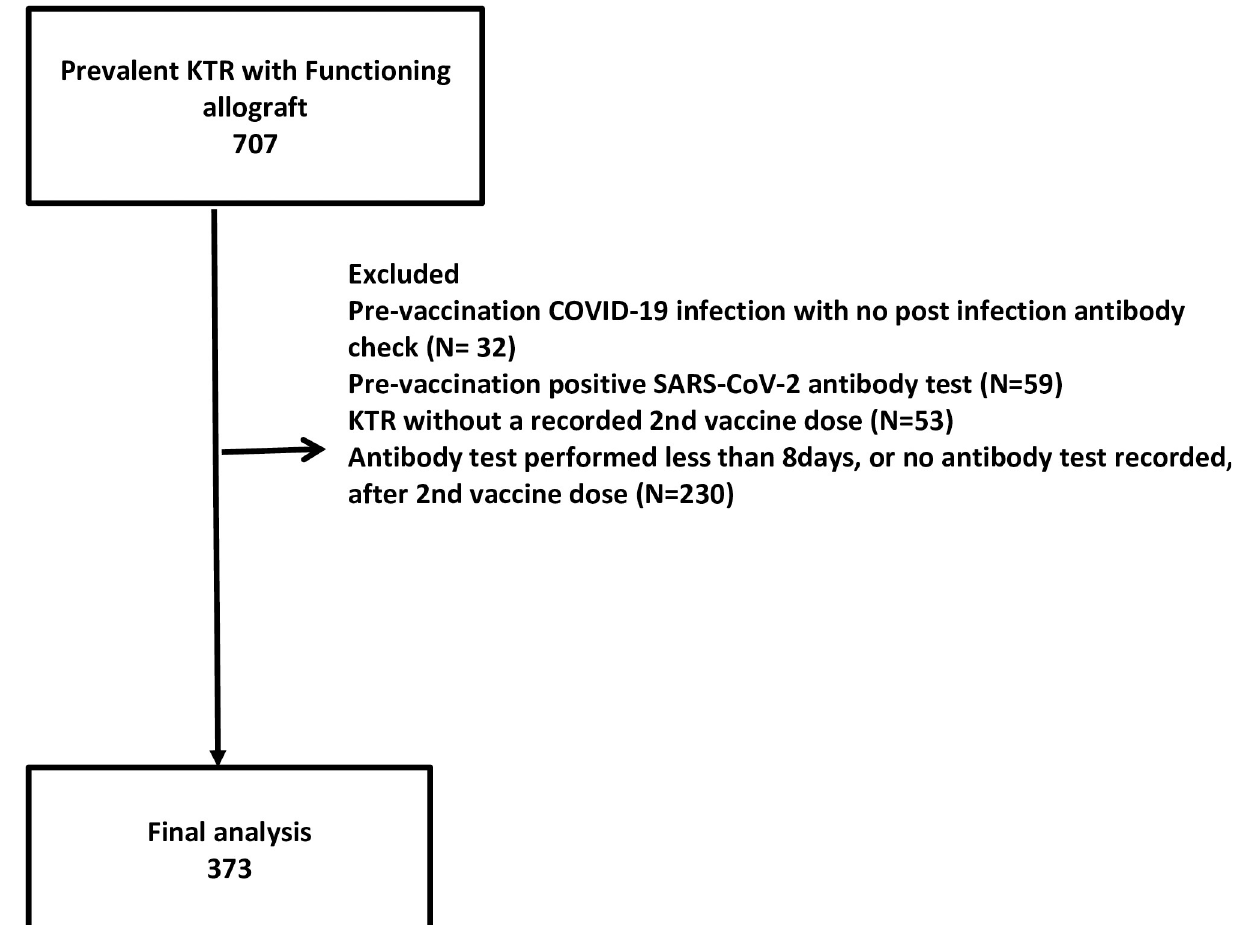
Fig 1. Cohort selection flow chart. COVID-19, coronavirus disease-2019; KTR, kidney transplant recipients; SARS-COV-2, severe acute respiratory syndrome coronavirus 2.